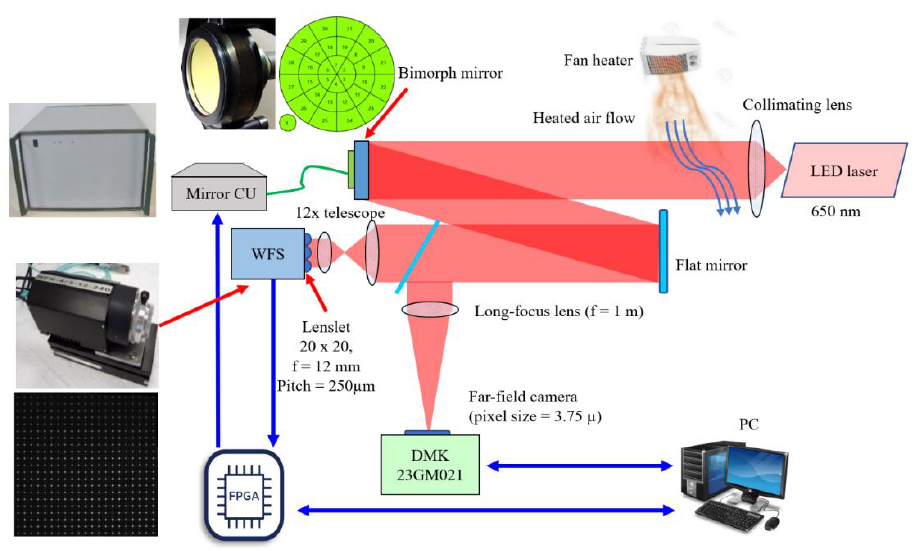
Figure 5. Adaptive optical system experimental setup. WFS—wavefront sensor; mirror CU—mirror control unit.